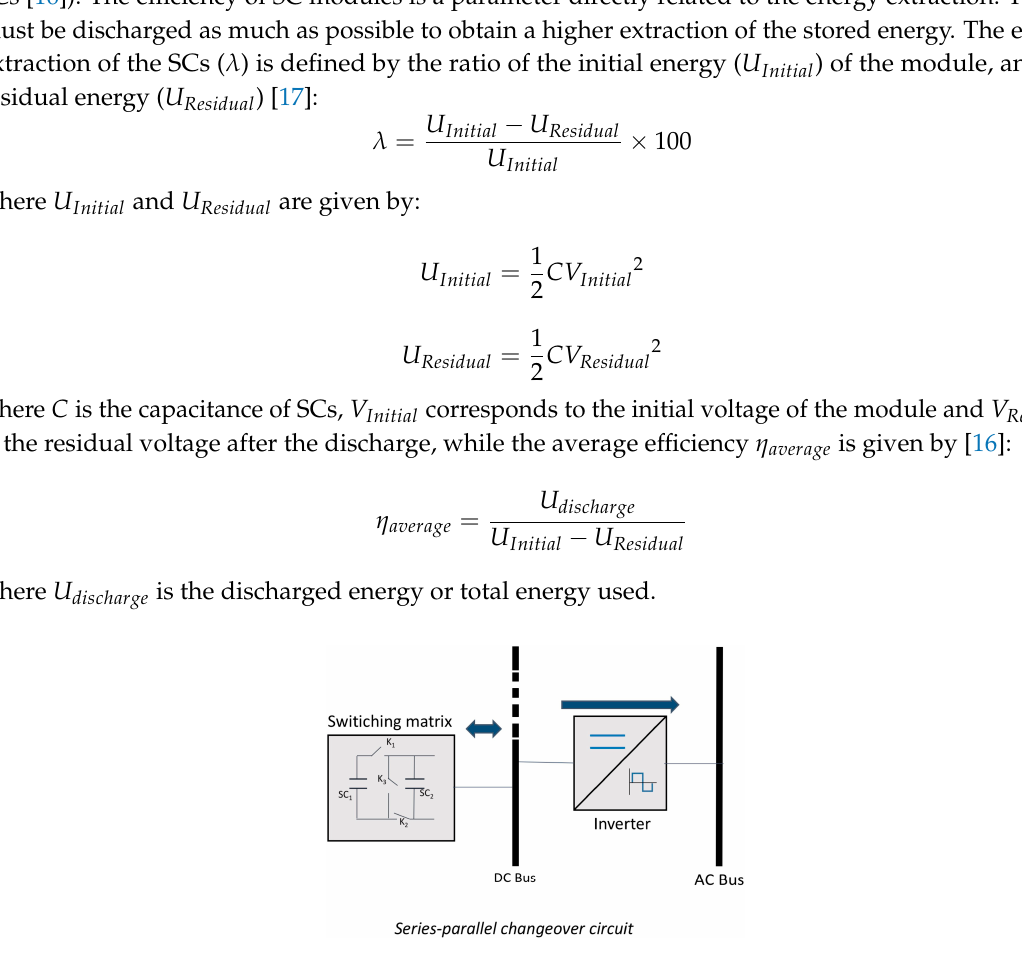
Figure 2. Series-parallel changeover circuit for DPGSs system.